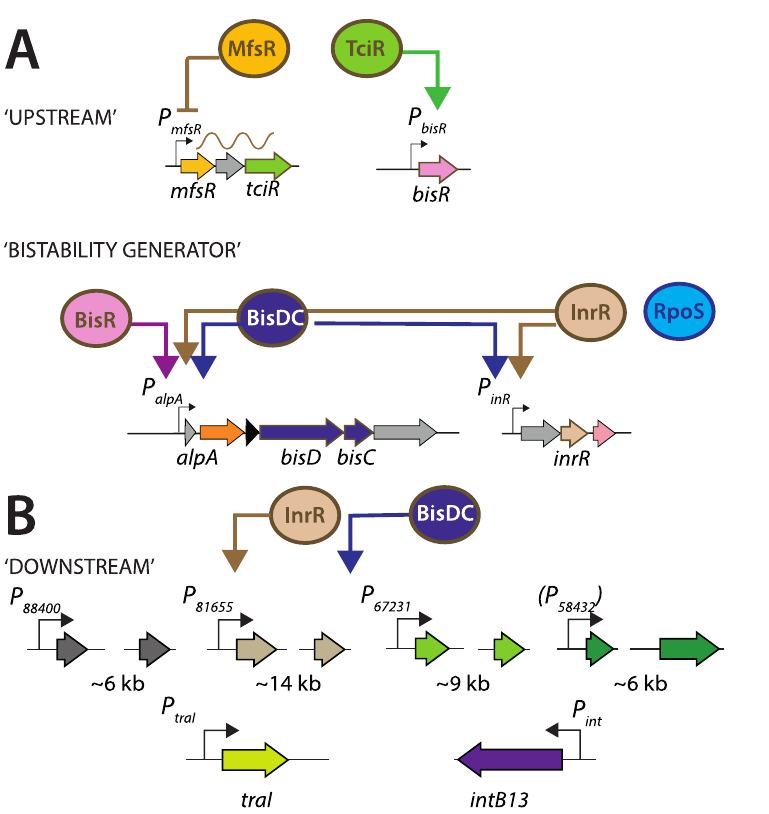
Fig 2. Proposed ICE clc transfer competence regulon. A Current state of knowledge of the ‘upstream’ factors MfsR, TciR and BisR, acting sequentially. The ‘bistability generator’ feedback loop initiated by BisR, but maintained by BisDC. RpoS being optimal for inrR expression. B Identified ‘downstream’ targets of the transfer competence regulon and their control by BisDC and InrR. Promoters from alpA onwards activated in the same tc cell subpopulation.